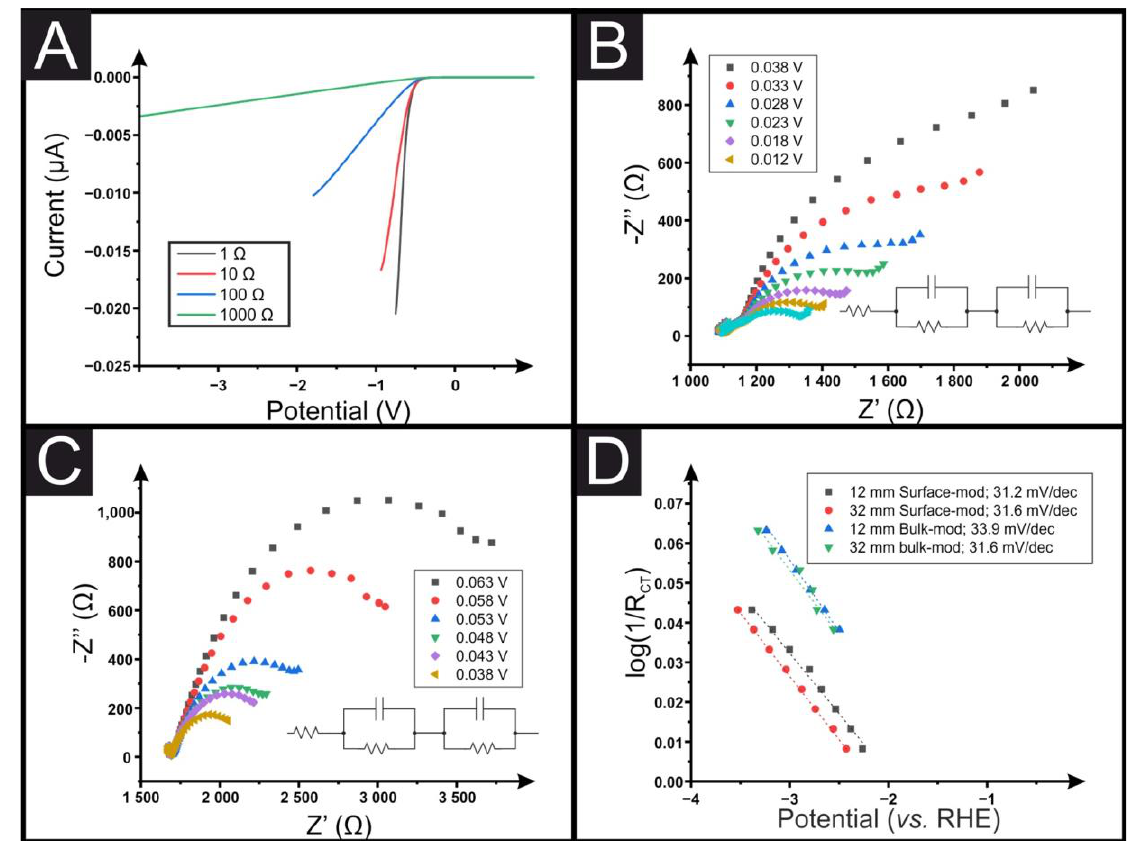
Figure 5. ( A ) Plot of the simulated LSVs for the HER with different resistance electrodes (1, 10, 100 and 1000 Ω ). Simulation parameters: scan rate = 100 mV s − 1 ; temperature = 298.2 K; electrode area = 0.07 cm 2 ; heterogeneous rate constant ( k 0 ) = 1 × 10 − 7 cm s − 1 [37]; concentration = 0.5 mol L − 1 ; diffusion coefficient of H + = 8.8 × 10 − 5 cm 2 s − 1 [38]. ( B ) EIS spectra for the HER using the Pt/C surface-modified 12 mm SPE at different applied potentials. Performed in H 2 SO 4 (0.5 M). ( C ) EIS spectra for the HER using the Pt/C bulk-modified 32 mm SPE at different applied poten- tials. Performed in H 2 SO 4 (0.5 M). ( D ) Plot of the log(1/R CT ) vs. applied potential for the Pt/C surface-modified and bulk-modified 32 and 12 mm